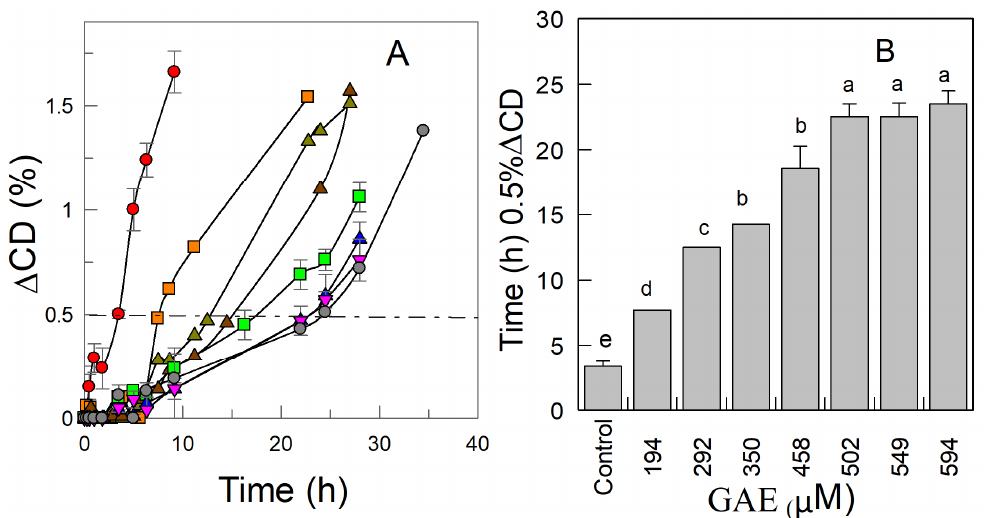
Figure 2. ( A ) E ff ects of the BH Bryophyllum extract concentrations on the variation in CDs formation with time in 4:6 (O / W) stripped fish oil-in-water emulsions. The control samples did not contain any antioxidant ( • - control, (cid:4) - BH 194 µ M, (cid:78) - BH 292 µ M, (cid:78) - BH 350 µ M, (cid:4) - BH 458 µ M, (cid:78) - BH 502 µ M, (cid:72) - BH 549 µ M, • - BH 594 µ M). The dashed line marks the hours required for an increase of 0.5% in CDs formation. ( B ) E ff ects of amount of BH Bryophyllum extract concentration (expressed as µ M GAE) on the time required to reach a 0.5% increase in CDs production. Experimental conditions: T = 25 ◦ C, Φ I = 6.68%. Data were expressed as average ± standard deviation and di ff erent letters indicate significant di ff erences ( α = 0.001).